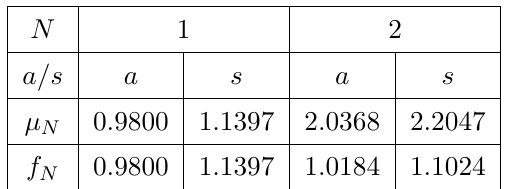
Table 1. The (cid:12)rst modes of the Kaluza-Klein spectrum for d = 1, in terms of their deviation f N (4.20) from the standard spectrum.